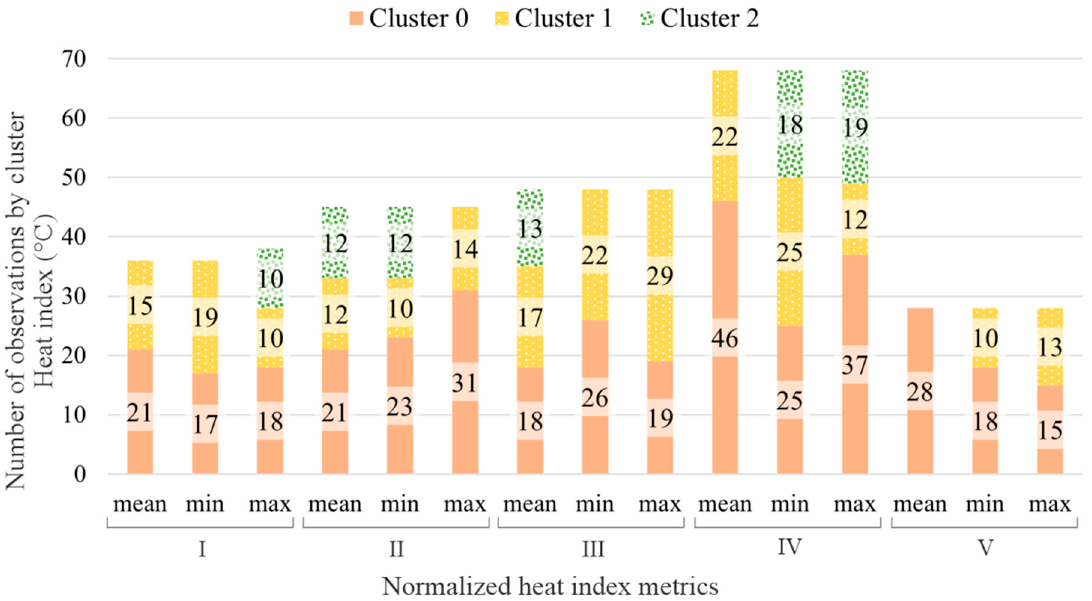
Figure 6. Stacked bars graph presenting the number of elements by cluster and heat index metric for each subject.